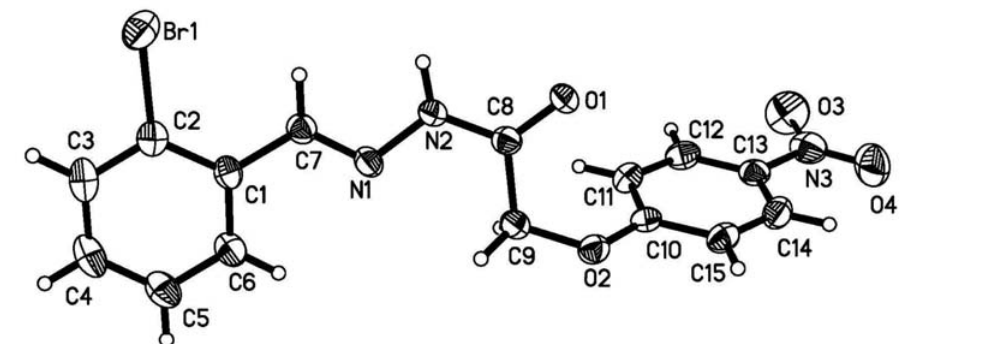
Figure 1. A perspective view of the molecular structure of 1 with the atom labeling scheme. Thermal ellipsoids are drawn at the 30% probability level.